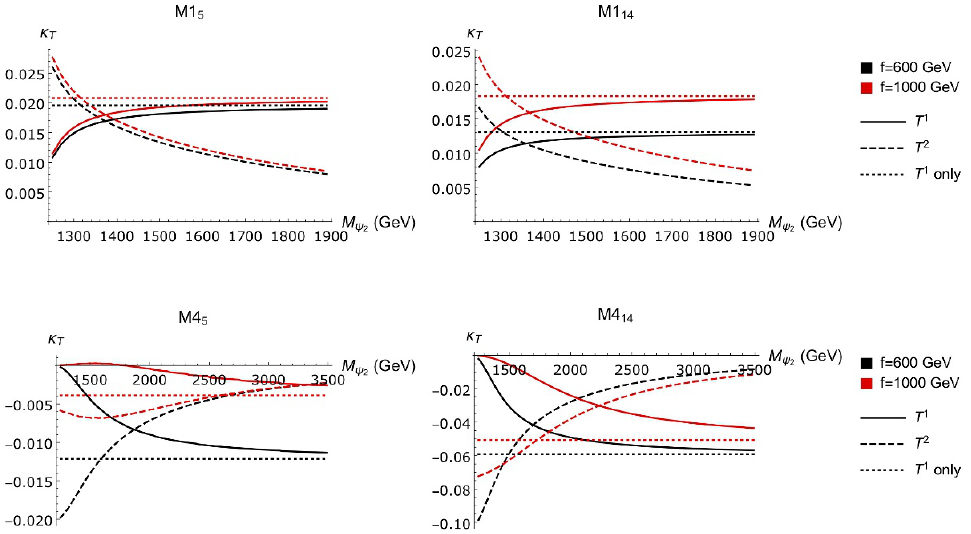
Figure 2 . The Yukawa couplings of the two light T 1 or T 2 top-partners as functions of the heavier vector-like mass, for M (cid:9) = 1200 GeV, y = 1, and f = 600 = 1000 GeV. The ‘ T 1 only’ results can 1 easily be veri(cid:12)ed from eq. (3.7) and eq.